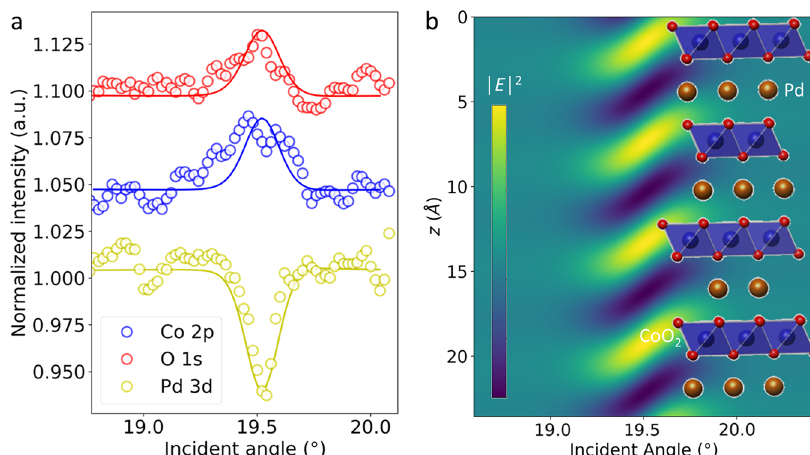
Fig. 3 Experimental and simulated rocking curves of core-level spectra of PdCoO 2 . a Rocking curves of Pd 3 d , Co 2 p , and O 1 s near the (0003) Bragg peak. Experimental data points are shown by circles while the lines are simulated rocking curves obtained from dynamical diffraction theory. b Calculated electrical fi eld strength ð E j j 2 Þ as a function of depth and incident angle.